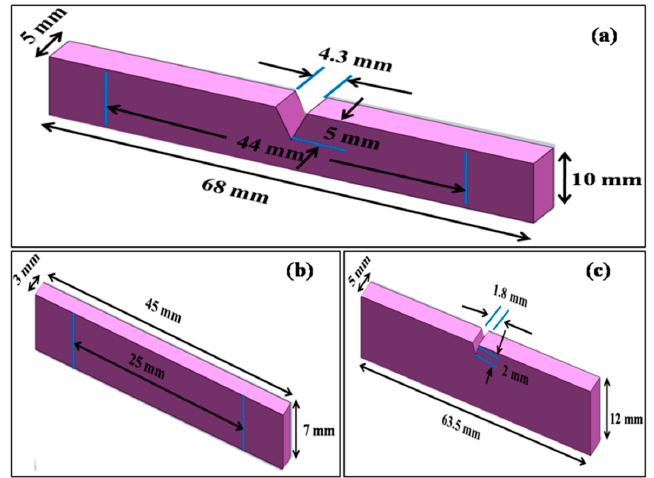
Figure 1. Geometry and dimension of ( a ) In-plane fracture toughness ( b ) Inter-laminar shear strength and ( c ) Izod impact test specimens.